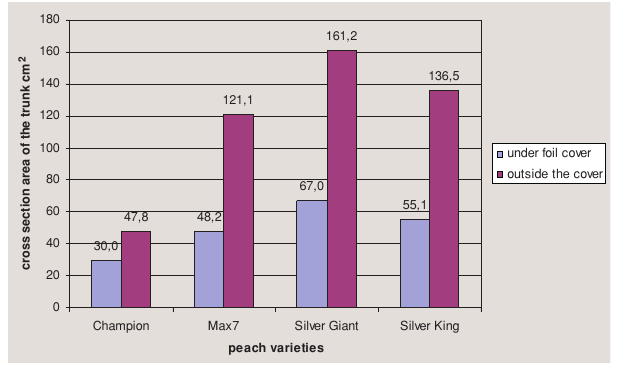
Figure 1. Cross section area of the trunks of peach trees grown under foil cover and outside the cover at an age of 8 years ( Debrecen-Pallag, 2010)